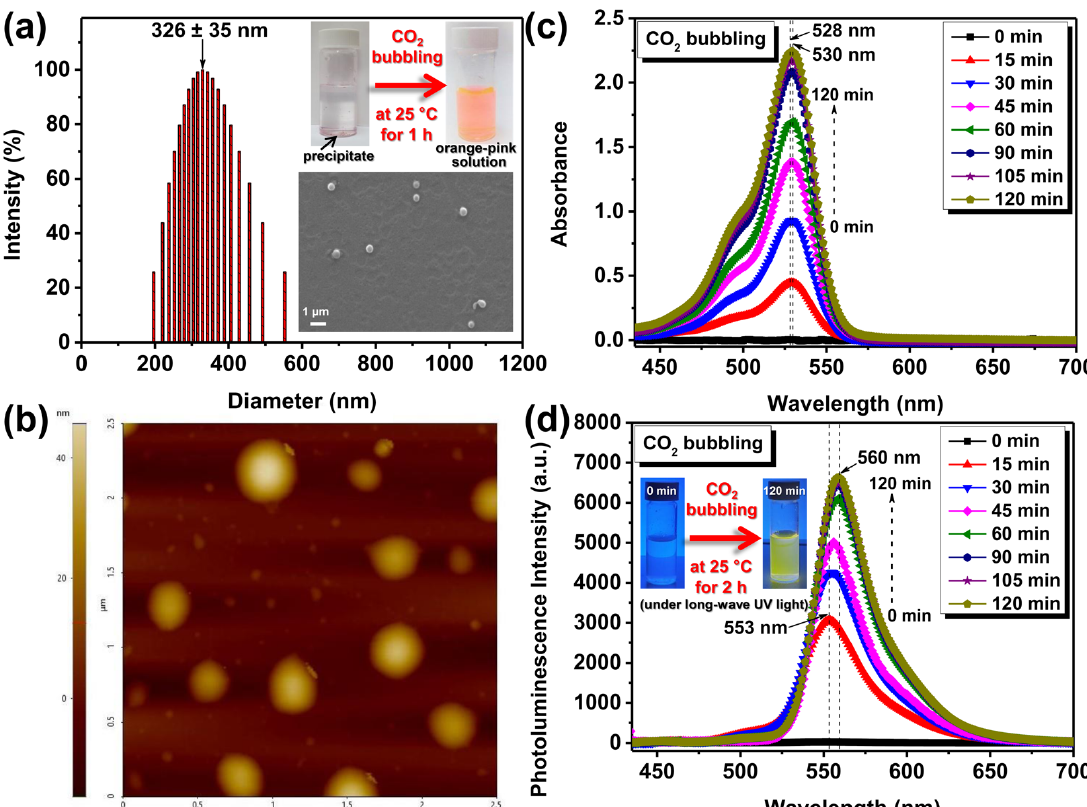
Figure 2. ( a ) DLS size distribution curve of I-R6G in water after CO 2 bubbling at 25 °C. The upper right inset photographs show the effect of CO 2 bubbling on the solubility of I-R6G in water. The bottom right inset is a SEM image of spin-coated CO 2 -treated I-R6G nanoparticles obtained at 25 °C. ( b ) AFM image of spin-coated CO 2 -treated I-R6G nanoparticles obtained at 25 °C. ( c ) UV-Vis and ( d ) PL spectra of I-R6G (0.1 mg/mL) in water obtained at 25 °C over time after various periods of CO 2 bubbling. The upper left inset photographs in ( d ) show the fluorescence behaviour of aqueous I-R6G solution under long-wavelength UV lamp illumination before and after CO 2